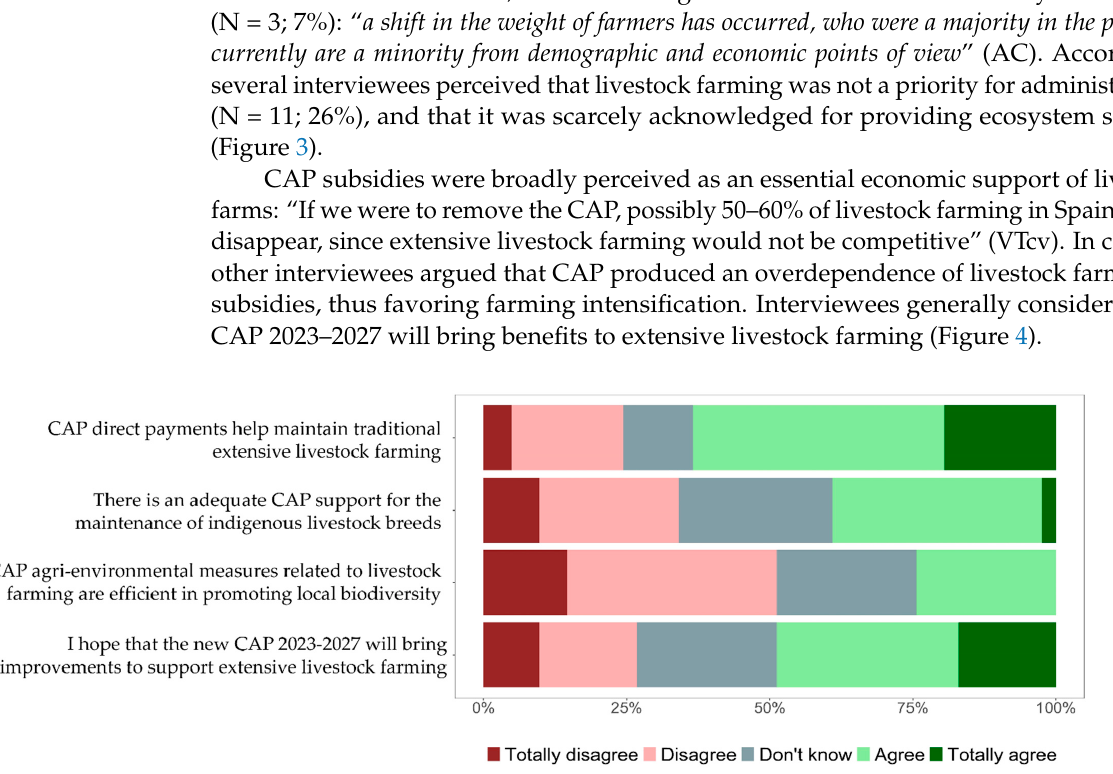
Figure 4. Positions of interviewed people regarding different issues related to the Common Agricultural Policy based on Likert scale responses from the questionnaires (N = 41). Values are expressed as the percentage of responses over the total number of people interviewed.